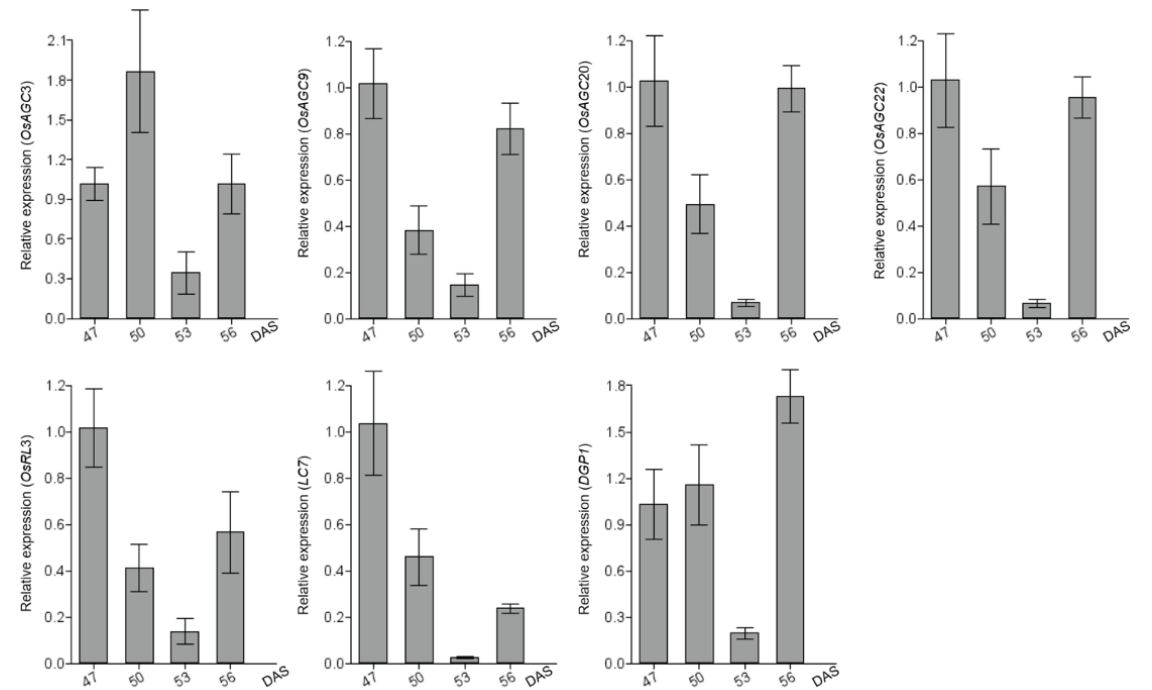
Figure 7. The expression profiles of four OsAGCs and three photosynthesis-related genes were evaluated by qRT–PCR in leaf-level at 47, 50, 53, and 56 days after sowing (DAS).